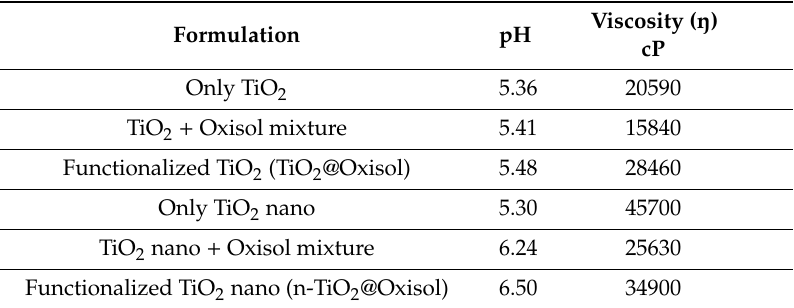
Table 2. pH and viscosity data for aqueous TiO 2